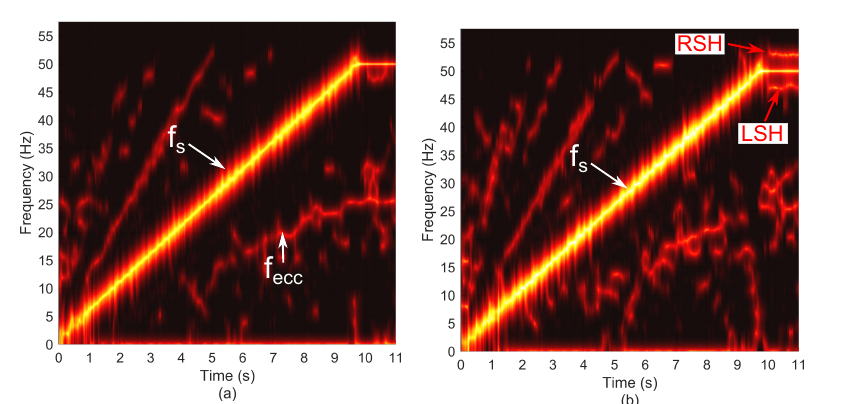
Figure 10. Time-frequency analyses of the IM stator current under startup transient and low load level for: ( a ) healthy motor and ( b ) a rotor with one full broken rotor bar.